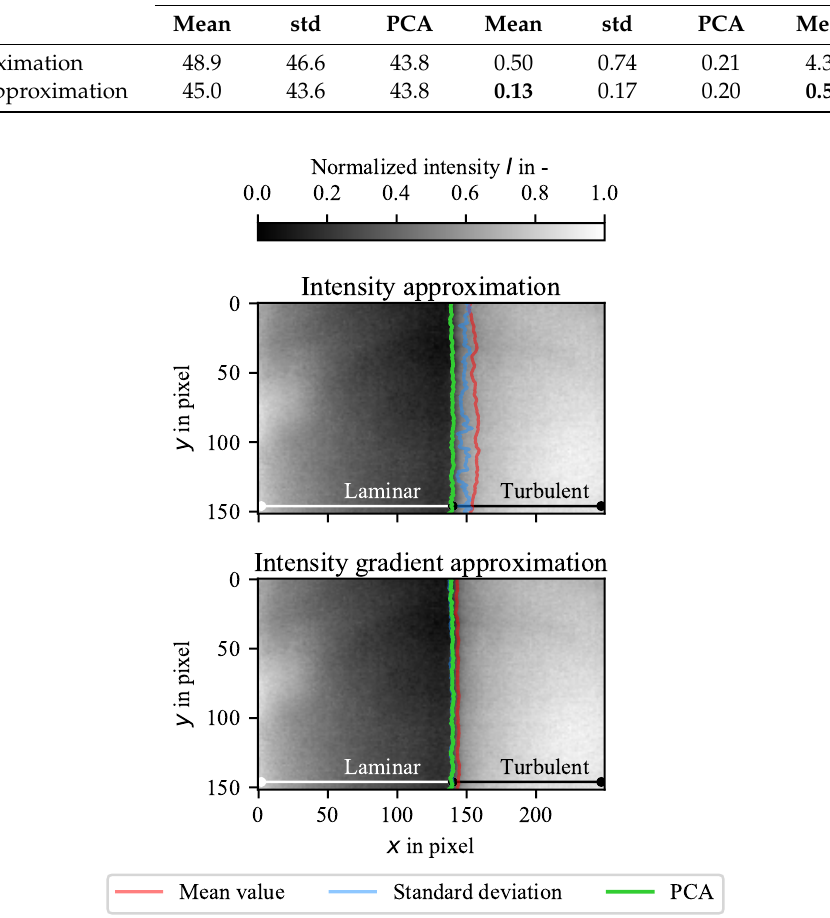
Figure 13. Comparison of the located laminar turbulent flow transition line by means of the temporal mean value (red), temporal standard deviation (blue) and PCA (green) flow visualization of the image series. Flow transition localization based on the approximation of the intensity profile (top) and approximation of the intensity gradient profile (bottom). The intensity gradient approximation method successfully locates the flow transition in each image with minimal random and systematic error due to the existence of a high gradient. The localization based on the intensity profile approxi- mation in the classical image processing methods, however, has a larger systematic error. This error is minimized if the PC flow visualization is used for the localization.